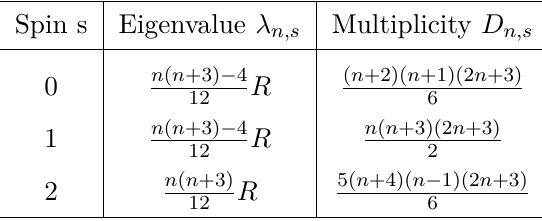
at n φ = 1 , and for T ¯ h at n φ = 0 0 0